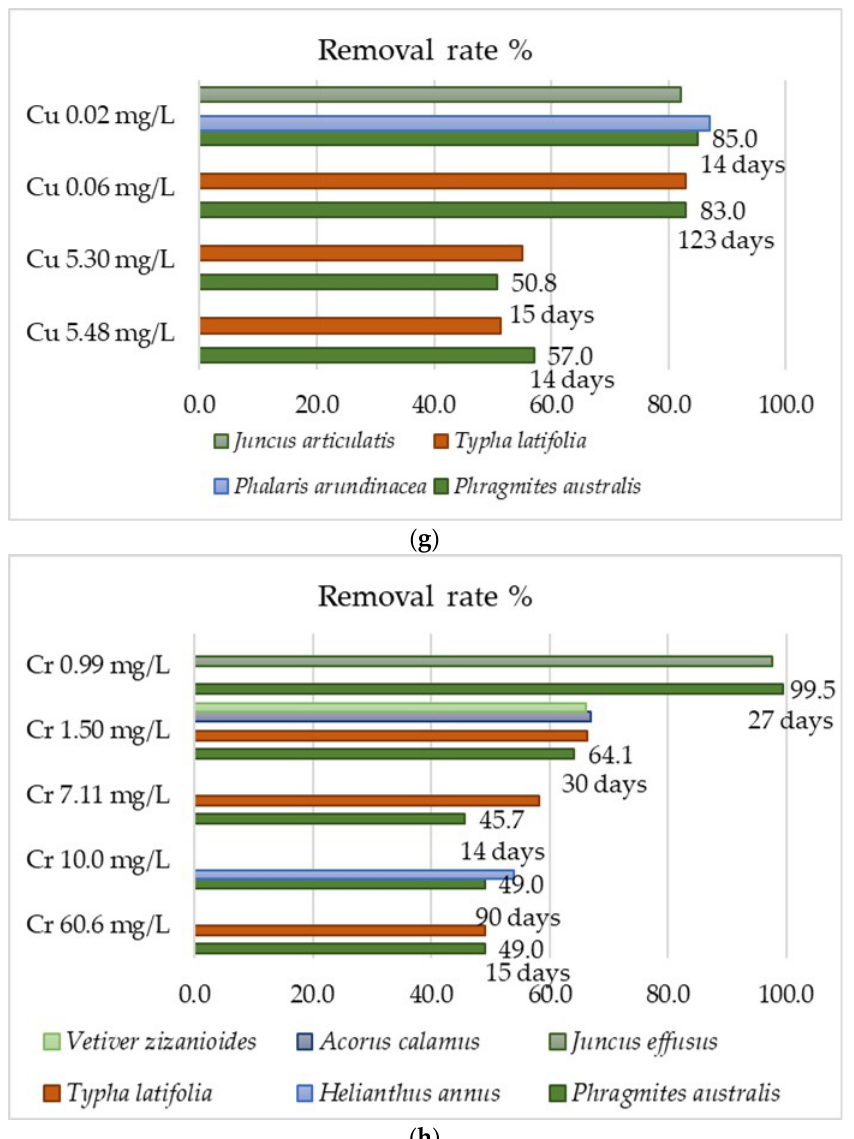
Figure 6. Heavy metals removal rate % for P. australis and the others emergent aquatic plants: ( a ) Mn, ( b ) Ni, ( c ) Pb, ( d ) Fe, ( e ) Cd, ( f ) Zn, ( g ) Cu, ( h ) Cr